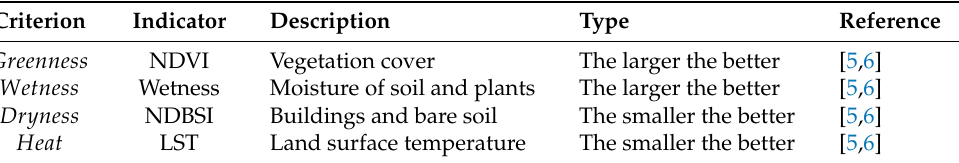
Table 1. Ecological criteria.